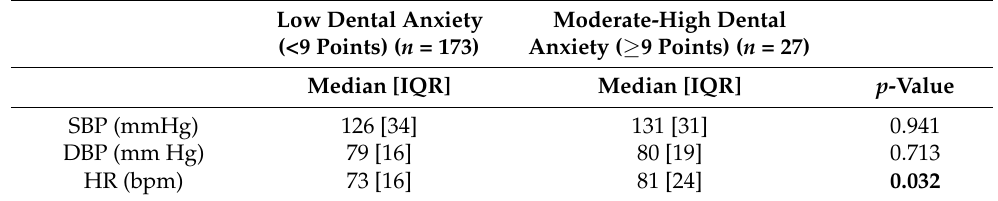
Table 7. Analysis of physiological parameter values between patients with different levels of